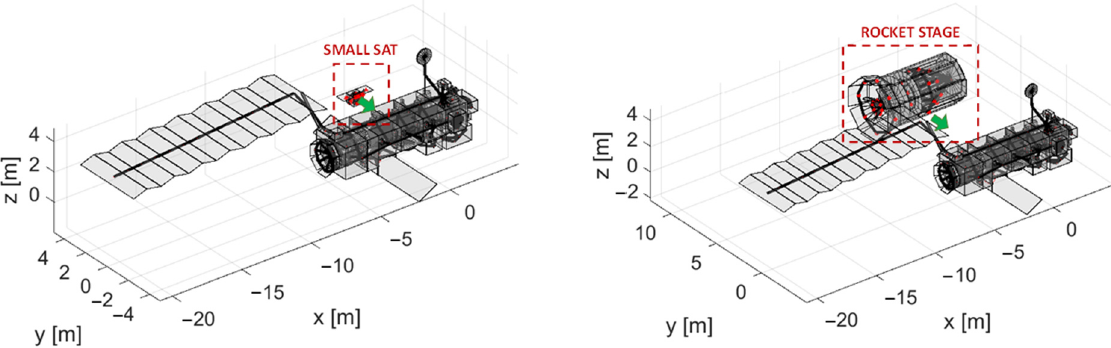
‘Figure 15. Simulated collision scenarios involving ENVISAT and a 100 kg small sat ( left ) or a 3-ton rocket stage ( right